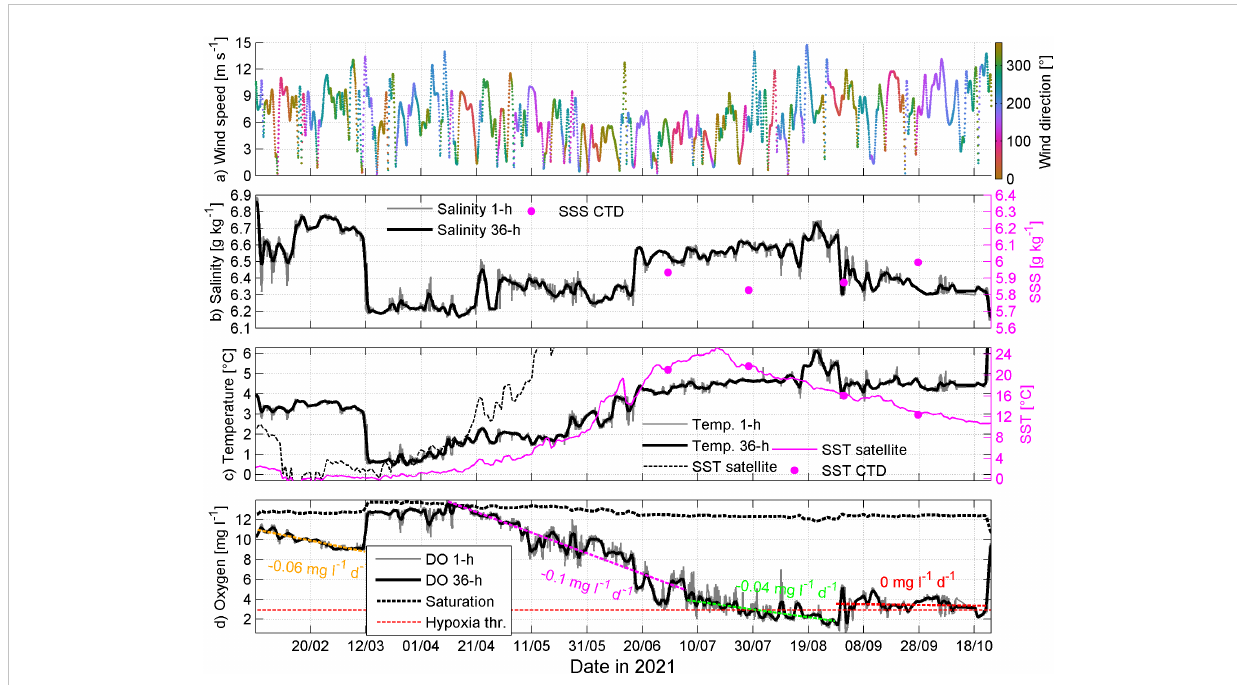
FIGURE 2 Wind speed and direction (ERA wind in Figure 1), salinity, temperature, and dissolved oxygen at 50 m depth in RD station from 28 January to 23 October 2021. Bold lines correspond to 36-h smoothed values. Sea surface temperature (from remote sensing as the purple line and CTD pro fi les as the purple dots) and salinity (dots) are shown in the middle panels (the scale of the right axis is different from the left